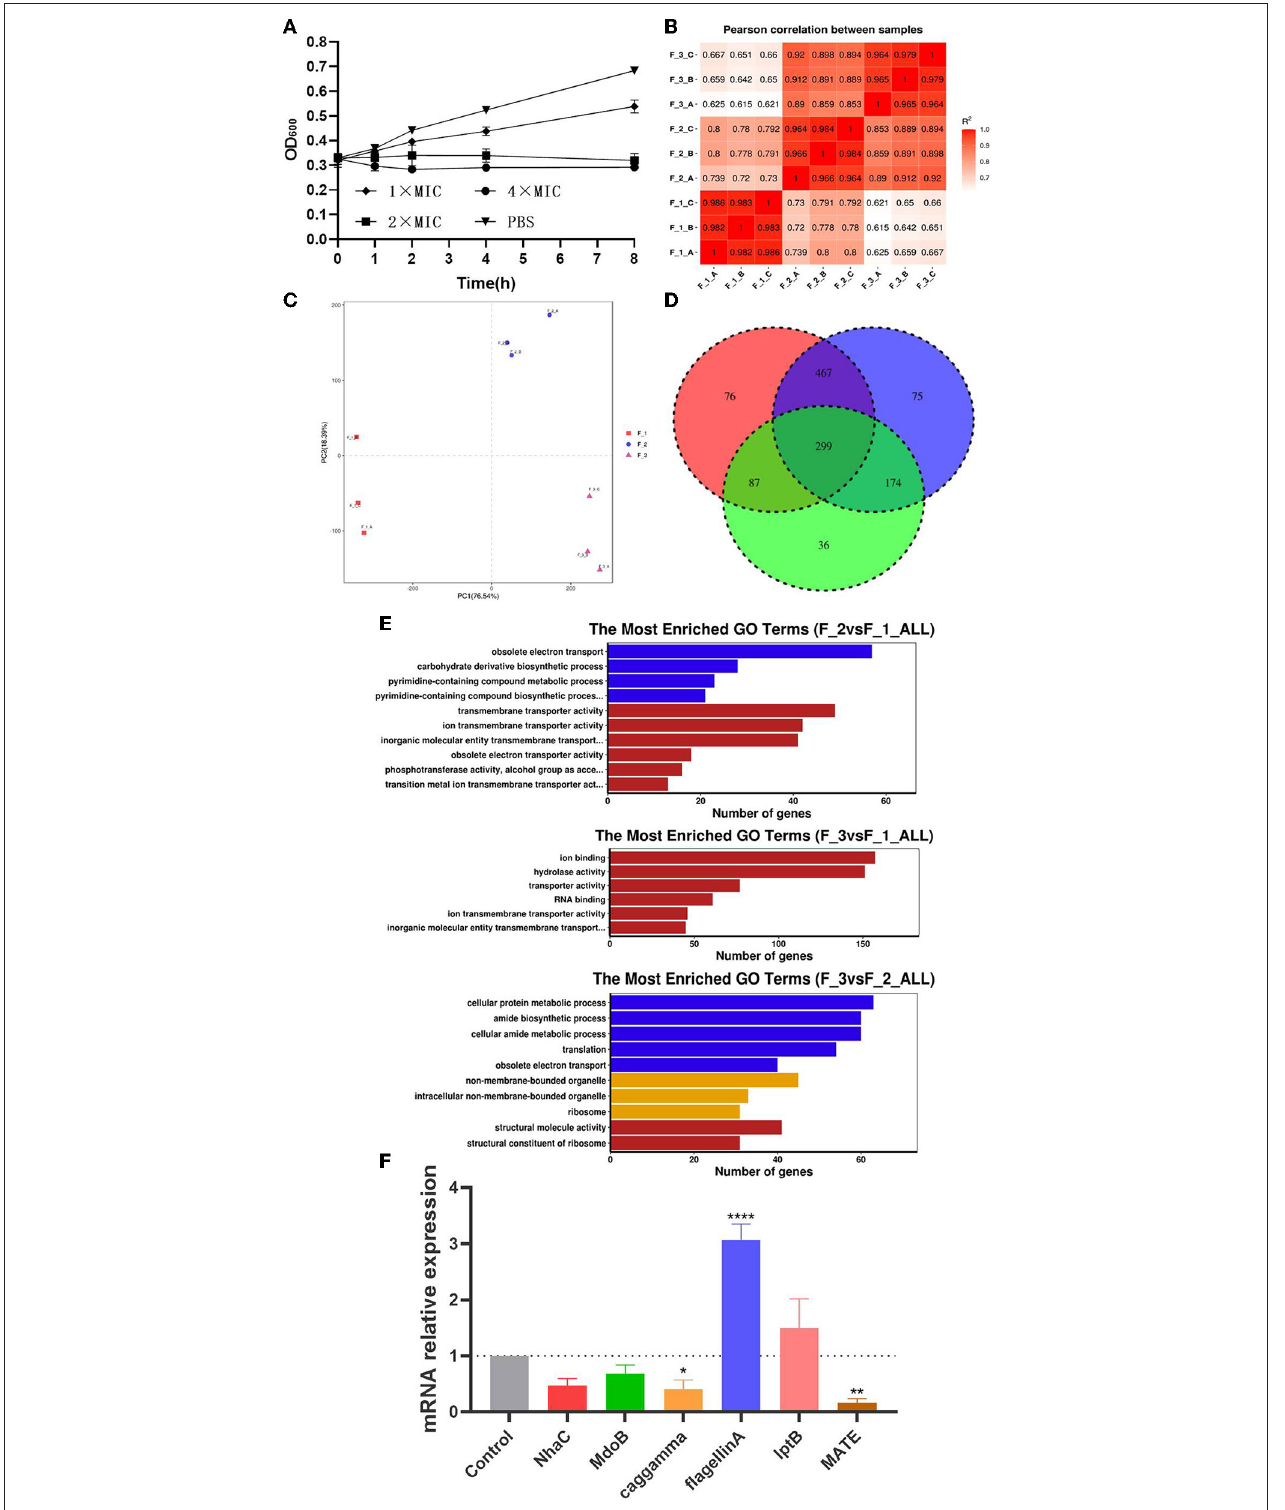
FIGURE 7 | Phillygenin inhibiting Helicobacter pylori by Transcriptome analysis. (A) The half inhibitory concentration curve; (B) the RNA-Seq correlation analysis; (C) the principal component analysis (PCA); (D) volcano (red represents the upregulation, green represents the downregulation, and blue represents no change); (E) the gene ontology (GO) enrichment analysis histogram of differentially expressed genes (blue represents biological processes, yellow represents the cellular component, and red represents the molecular function); (F) the changes in the relative expression quantity of the mRNA of differentially expressed genes detected by the transcriptome sequencing in suspended bacteria treated with phillygenin at a concentration of two times of the MIC. * P < 0.05, ** P < 0.01, ***P < 0.001.